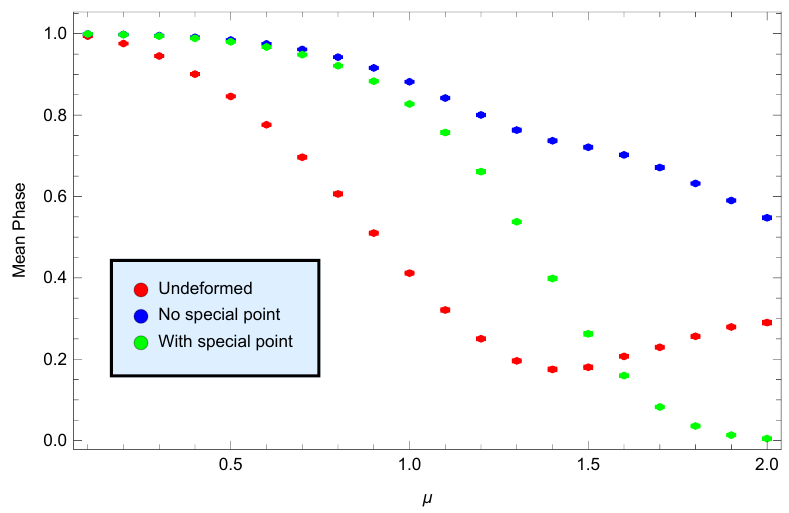
Figure 1 . The mean phase factor as a function of µ for d = 1 , L = 8 , and m = 1 . For small values of µ the symmetric treatment of all points and the new approach in which there is a special point lead to similar phase factors. From about µ = 1 the results begin to diverge, with the phase of the formulation with the special point being inferior and at some stage even worse than that of the undeformed